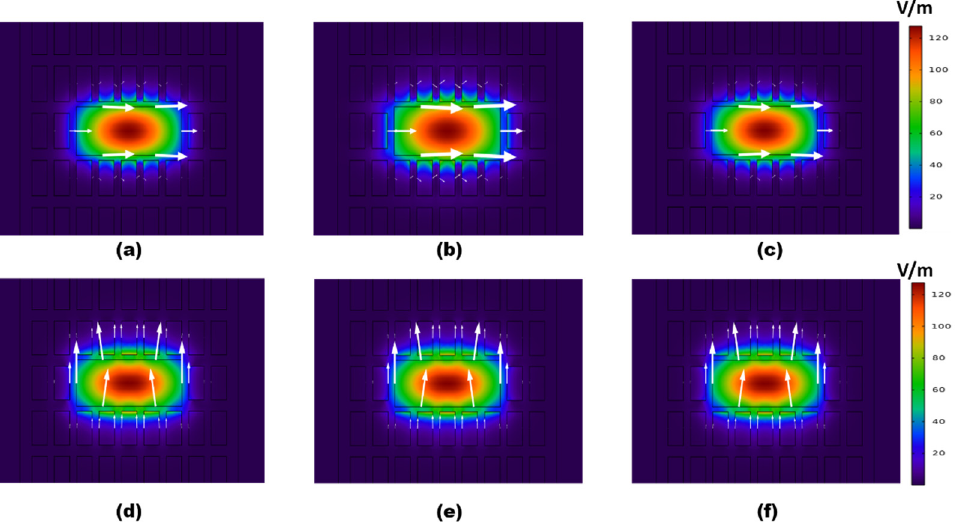
Figure 3. The electric field distribution of the fundamental mode for the ( a – c ) x-polarized mode and the ( d – f ) y-polarized mode at f = 0.75 THz, C = 4, 8, and 12 µmol/L, respectively. The initial dimensions shown in Table 1 are used.